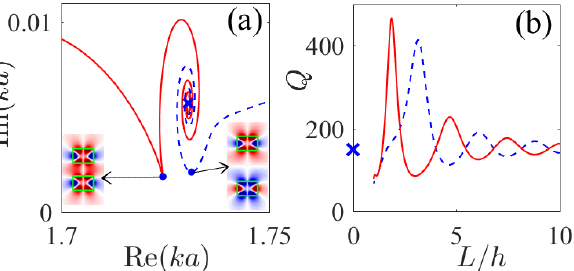
Figure 5. ( a ) Evolution of the hybridized bonding (solid) and anti-bonding (dash) resonances under variation of the distance between the disks L at the aspect ratio a / h = 0.71. Insets show the tangential component E φ of electric field. Cross marks the resonance of the isolated disk. ( b ) Evolution of the Q factors vs the